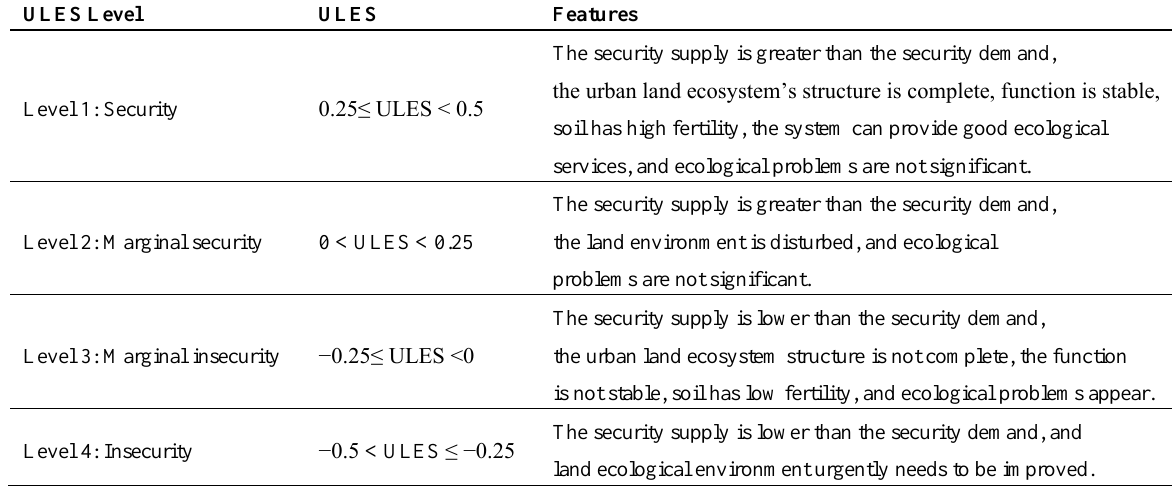
Table 2. Classification standards of land ecological